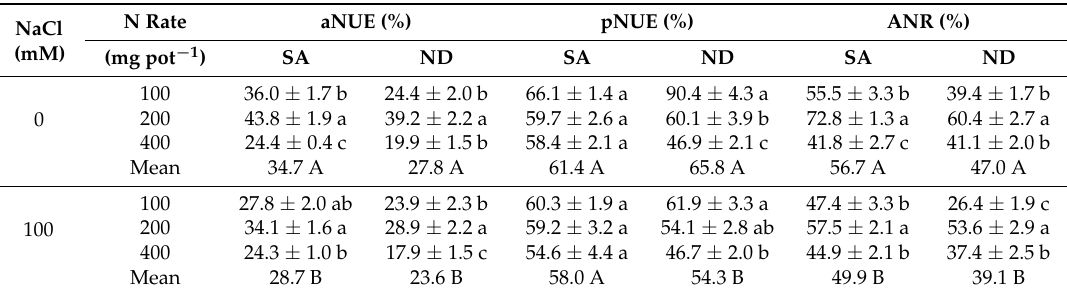
Table 10. Effects of salinity and nitrogen rate on agronomic nitrogen use efficiency (aNUE), physiological nitrogen efficiency (pNUE) and apparent nitrogen recovery (ANR) of the two oat genotypes (SA vs. ND) in a controlled greenhouse